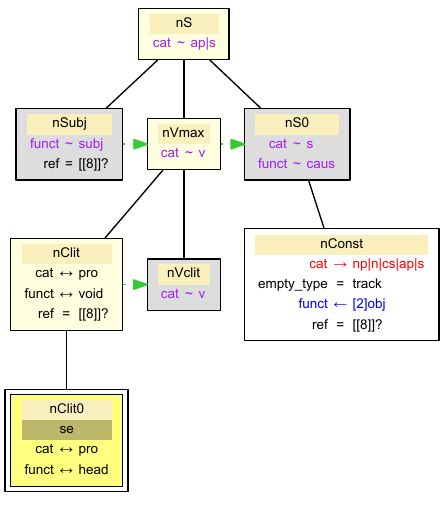
Frigram: a French Interaction Grammar